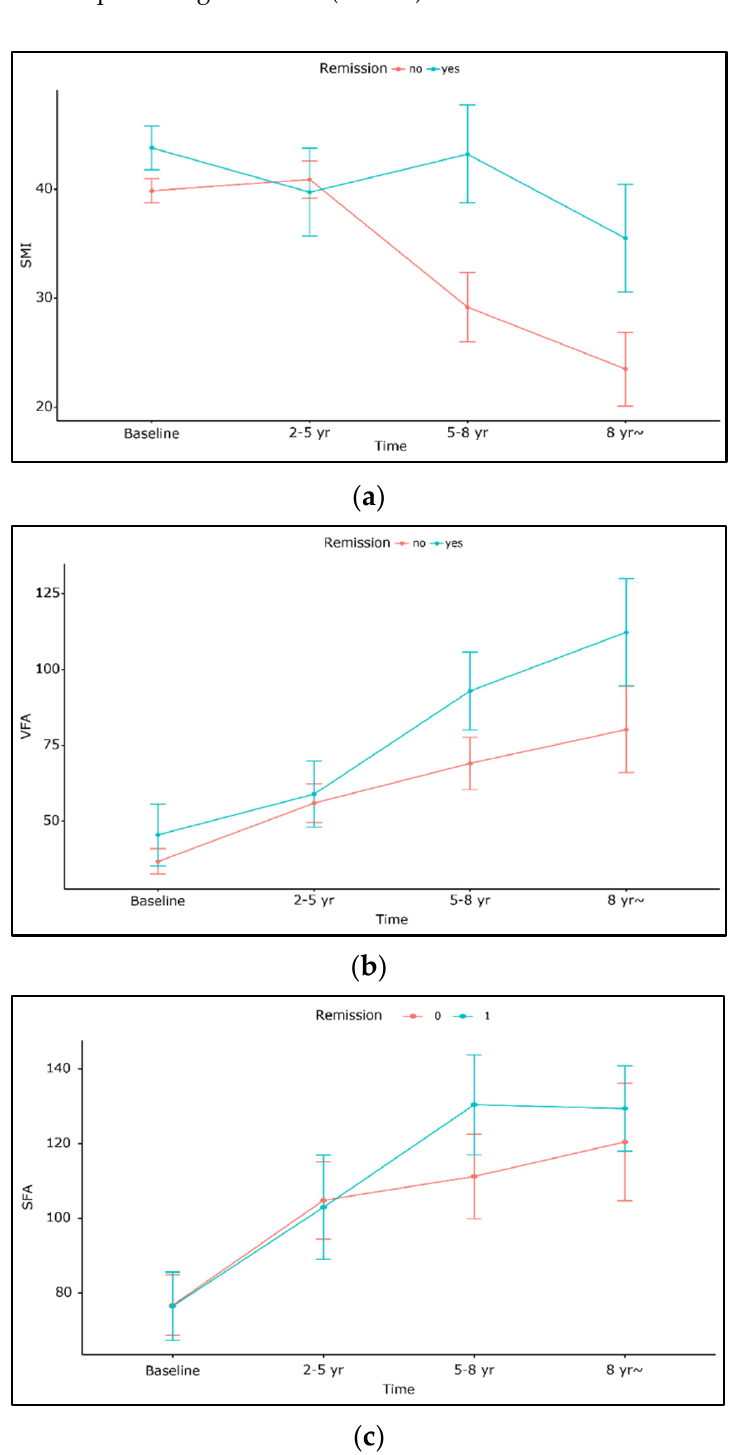
Figure 3. Comparison of changes in body composition according to presence or absence of remission. ( a ) SMI, ( b ) VFA, ( c ) SFA. Table 4. Logistic regression analysis predicting remission.